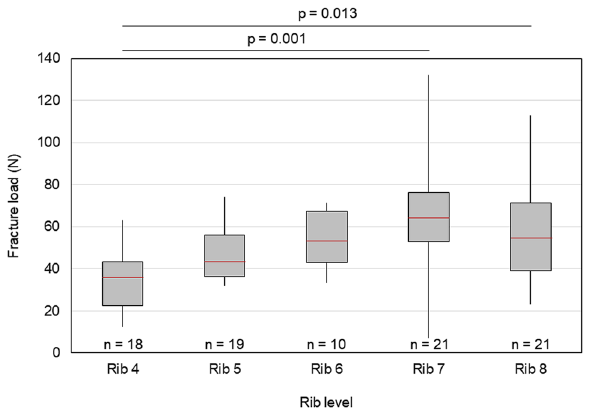
Figure 2. Boxplot diagram illustrating the effect of rib level on fracture load. Median values are depicted as red lines, the boxes include the 25th to 75th percentile, and the whiskers represent the maximum and minimum